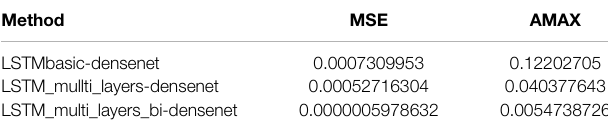
TABLE 3 | Results of each model